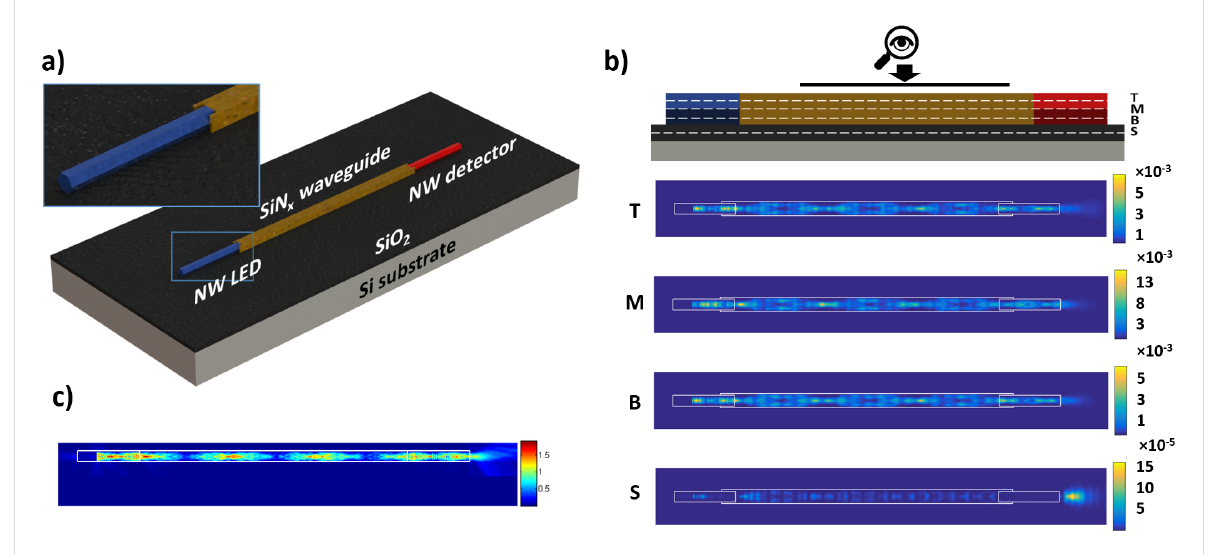
Figure 4: (a) Schematic illustration of the 3D FDTD simulation model consisting of a NW LED, waveguide and a NW photodetector with the opti- mized parameters. (b) Schematic view of layers and the top-view Poynting vector distributions (phase of the plane wave source is 0) in different hori- zontal layers (T, M and B: top, middle and bottom layers in the waveguide, respectively. S: horizontal layer in SiO 2 ). (c) Side view of the electric field distribution in the vertical cross-sectional layer in the middle of the